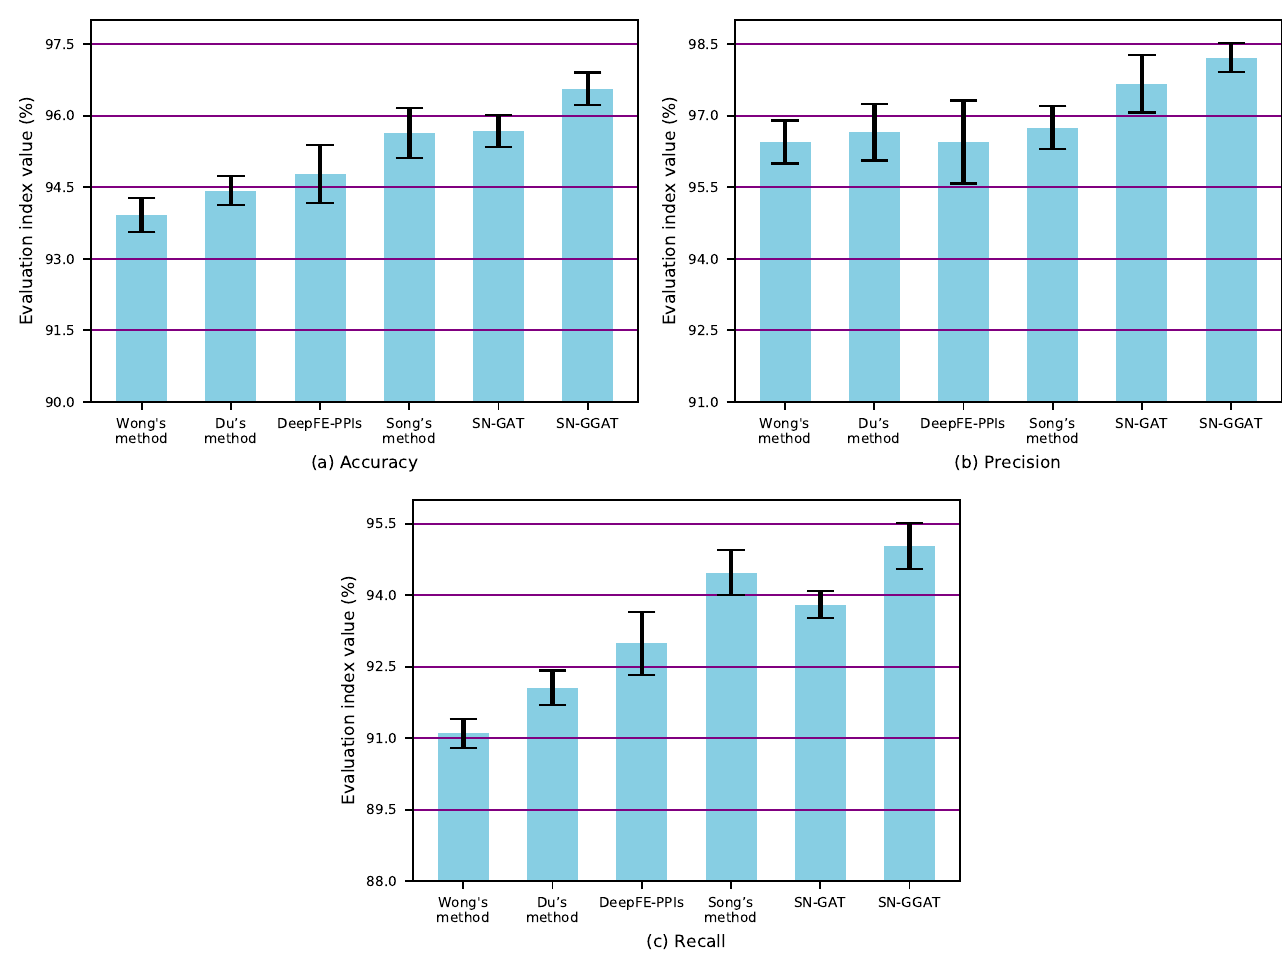
Figure 7. Accuracy, Precision, and Recall values (Mean ± SD) of SN-GGAT method and the compared